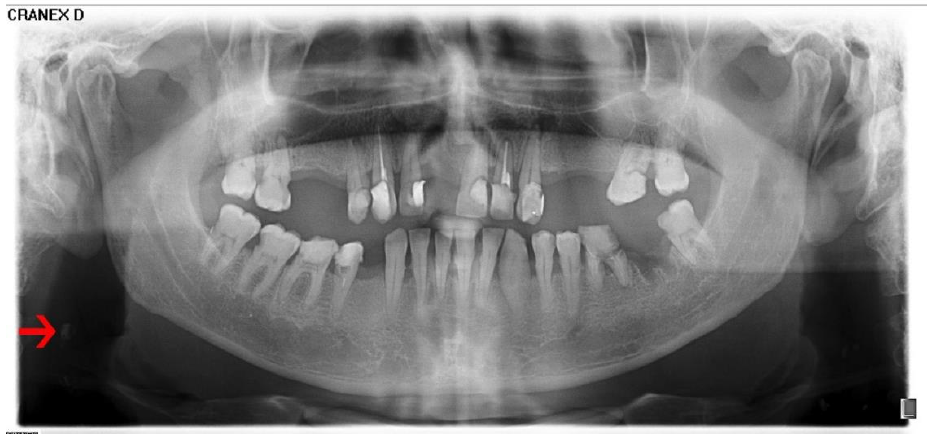
Figure 1. Panoramic radiograph with a detectable carotid artery calcification (red arrow).